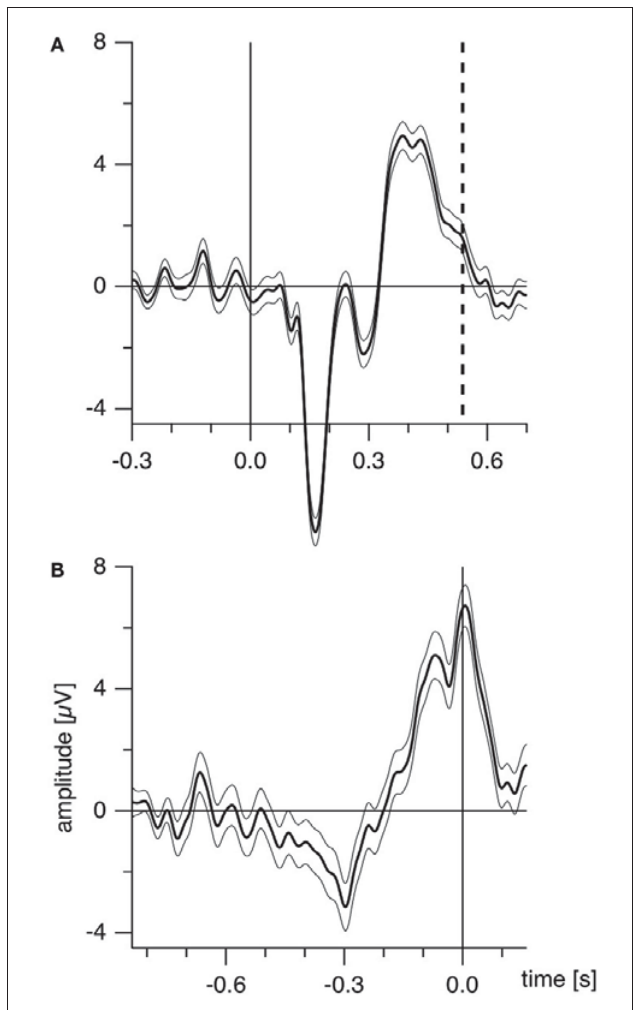
FIGURE 2 | Estimating manual reaction time variance. Participants observed unambiguous cubes (similar to Figure 1B ) that randomly reversed (16 times per minute on the average) and indicated manually each perceived orientation reversal. (A) ERP traces ( ± SEM) from the occipital location of one participant with the exogenous reversal instance as time reference for averaging (vertical line) are seen. Sharply defined early ERP components result; the reaction time is widely scattered (200ms interquartile range; dashed line indicates median reaction time). (B) The same EEG data averaged backward with reaction times as time references (vertical line).The early visual ERP components are largely obliterated. Only the late positivity is roughly similar to (A) .The Onset Paradigm ( Figure 4 ) avoided this